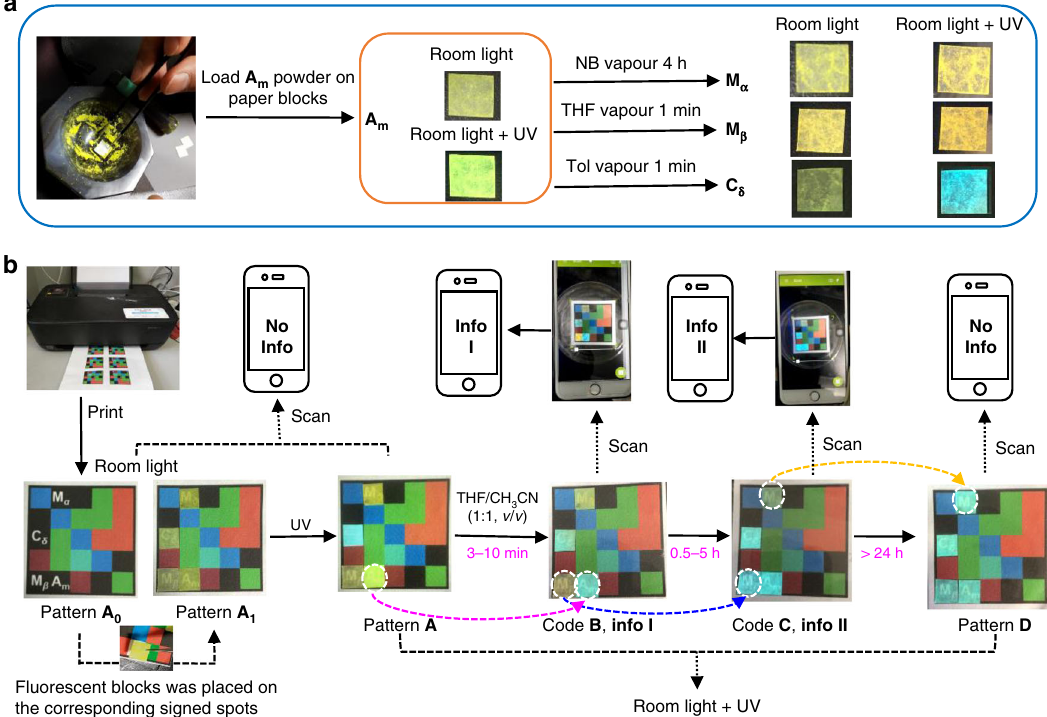
Fig. 5 Schematic representation of a 4D code information system based on a time-dependent organic vapour-based response. a Preparation of code blocks A m , M α , M β , and C δ . b Transformation and masking mad possible by using (i) an original printed colour pattern, (ii) room and/or UV light, and (iii) the time-dependent organic vapour-induced changes in the luminescent features of the constituent code blocks, A m , M α , M β , and C δ . Additional photographs of the various patterns are included in the Supporting